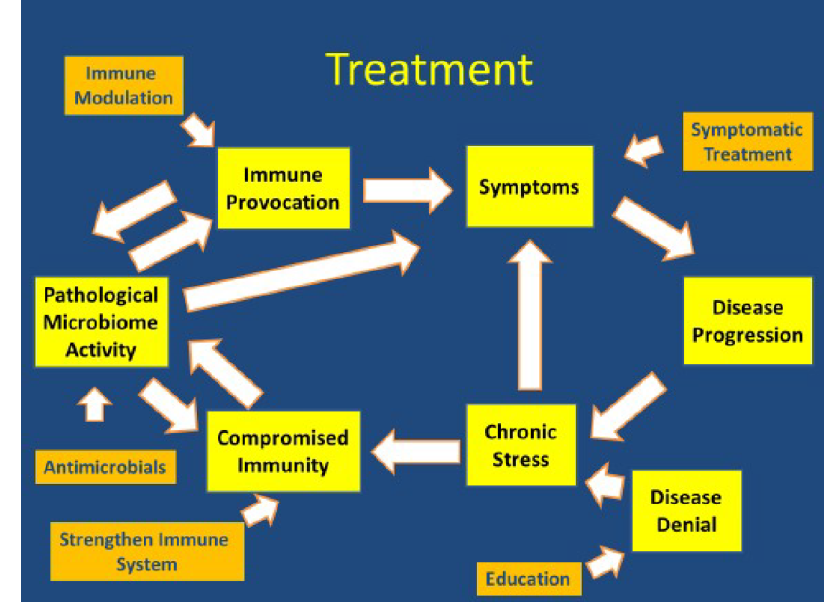
Figure 3. Treatment. Figure 3.